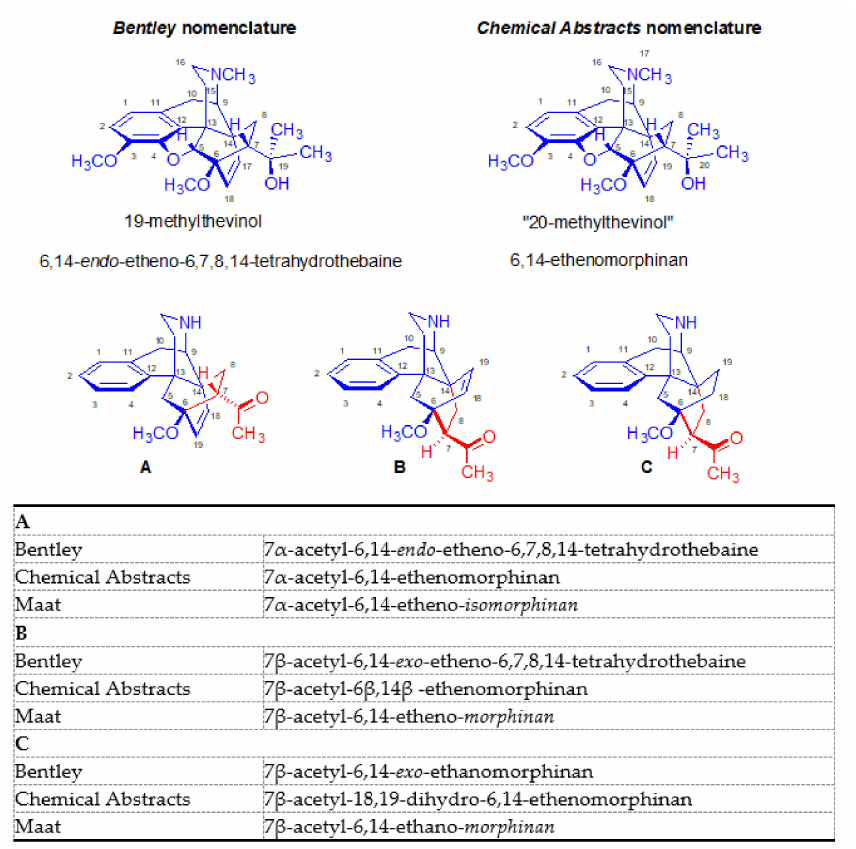
Figure 5. Nomenclature systems and numbering of Diels–Alder adducts of morphinan-6,8- dienes